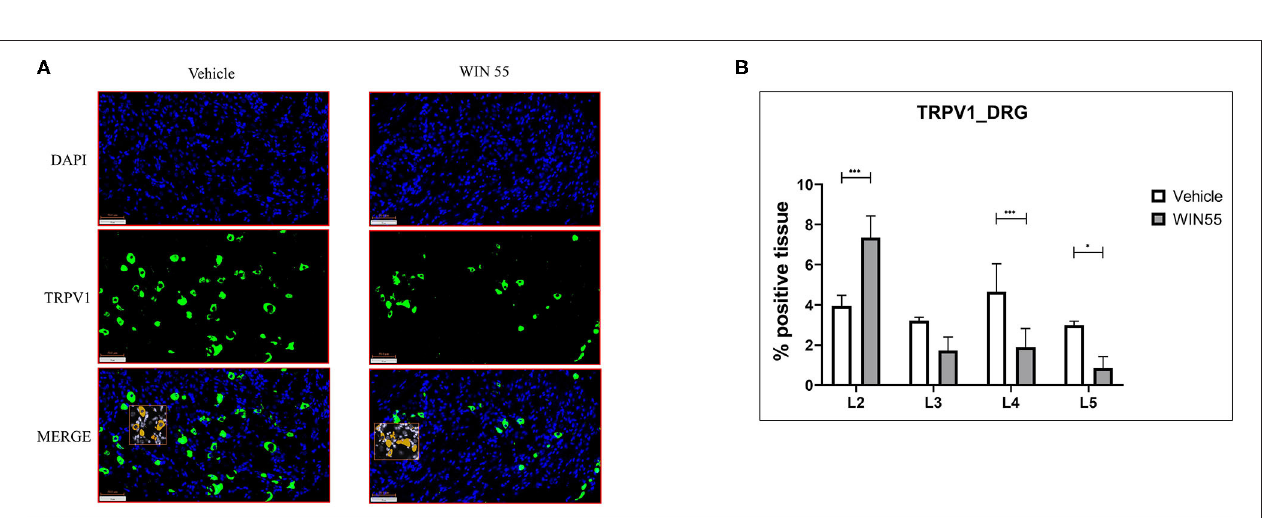
FIGURE 5 | Cannabinoid receptor stimulation alters TRPV1 expression in the dorsal root ganglia of mice with endometriosis. Lumbar region DRG from L1 to L5 were analyzed for TRPV1 expression through immunofluorescence. (A) Representative images of blue (DAPI positive) and green (TRPV1 positive) channel and merged (DAPI and TRPV1 positive) layers show TRPV1 expression in DRG isolated from both vehicle and WIN 55 treated animals. (B) Statistical analysis of TRPV1 expression showed increased abundance in L2 of DRG isolated from WIN 55 treated mice, whereas L4 and L5 DRG showed significantly reduced expression when compared with mice treated with vehicle. The orange box within the immunofluorescence images represents the analysis used in this study. Scale bar 100 µ m. Ordinary two-way ANOVA with Sidak post-hoc . * P < 0.05 *** P < 0.001.